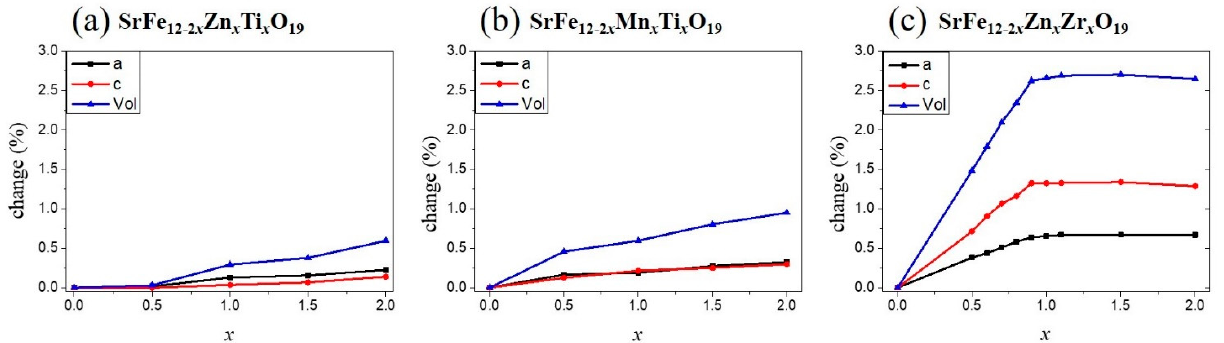
Figure 2. Changes (%) in lattice parameters a , c , and cell volume of ( a ) SrFe 12 − 2 x Zn x Ti x O 19 , ( b ) SrFe 12 − 2 x Mn x Ti x O 19 ( x = 0, 0.5, 1.0, 1.5, 2.0), and ( c ) SrFe 12 − 2 x Zn x Zr x O 19 ( x = 0, 0.5, 0.6, 0.7, 0.8, 0.9, 1.0, 1.1, 1.5, 2.0) samples.